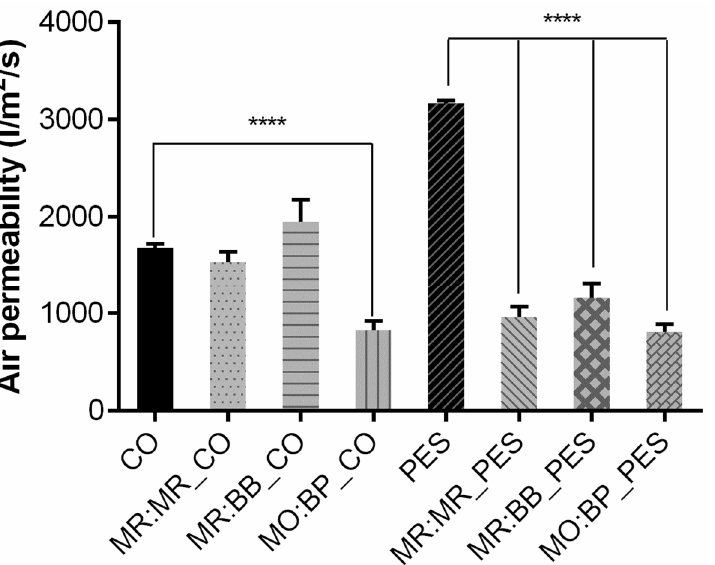
Figure 5. Air permeability measurement of cotton (CO) and polyester (PES) before and after coating with different pH-sensitive formulations: methyl red and bromothymol blue (MR:BB); methyl red and methyl red sodium salt (MR:MR); and methyl orange and bromocresol purple (MO:BP), (n = 5, ±SD), **** p < 0.0001 (one-way ANOVA, Šídák’s test).